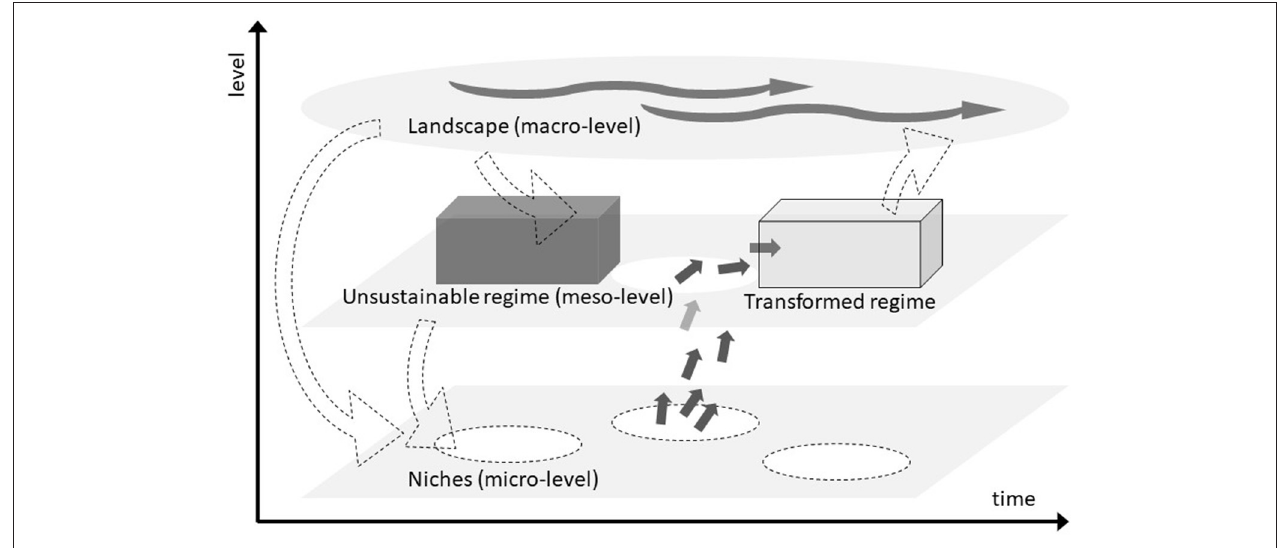
FIGURE 1 | Interactions of different levels in the transformation of socio-technical systems (adapted from Geels,